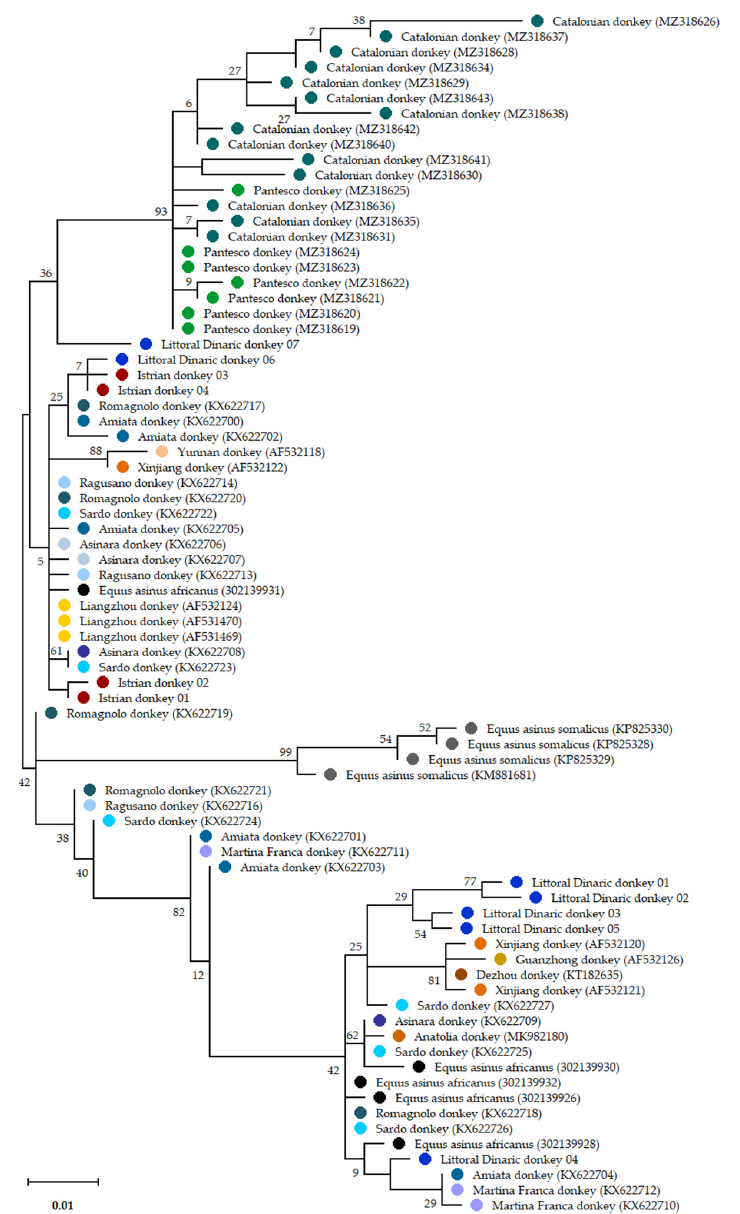
Figure 6. Maximum likelihood phylogenetic tree from eleven mtDNA D-loop haplotypes of Croatian local breeds (Littoral-Dinaric donkey; Istrian donkey) and sixty-nine haplotypes of Italian, Spanish, Chinese, and Turkish donkey breeds, including nine African wild ass sequences ( Equus asinus africanus, Equus asinus somalicus ). Bootstrap values (expressed as percentages of 1000 replications) are shown at the branch points.